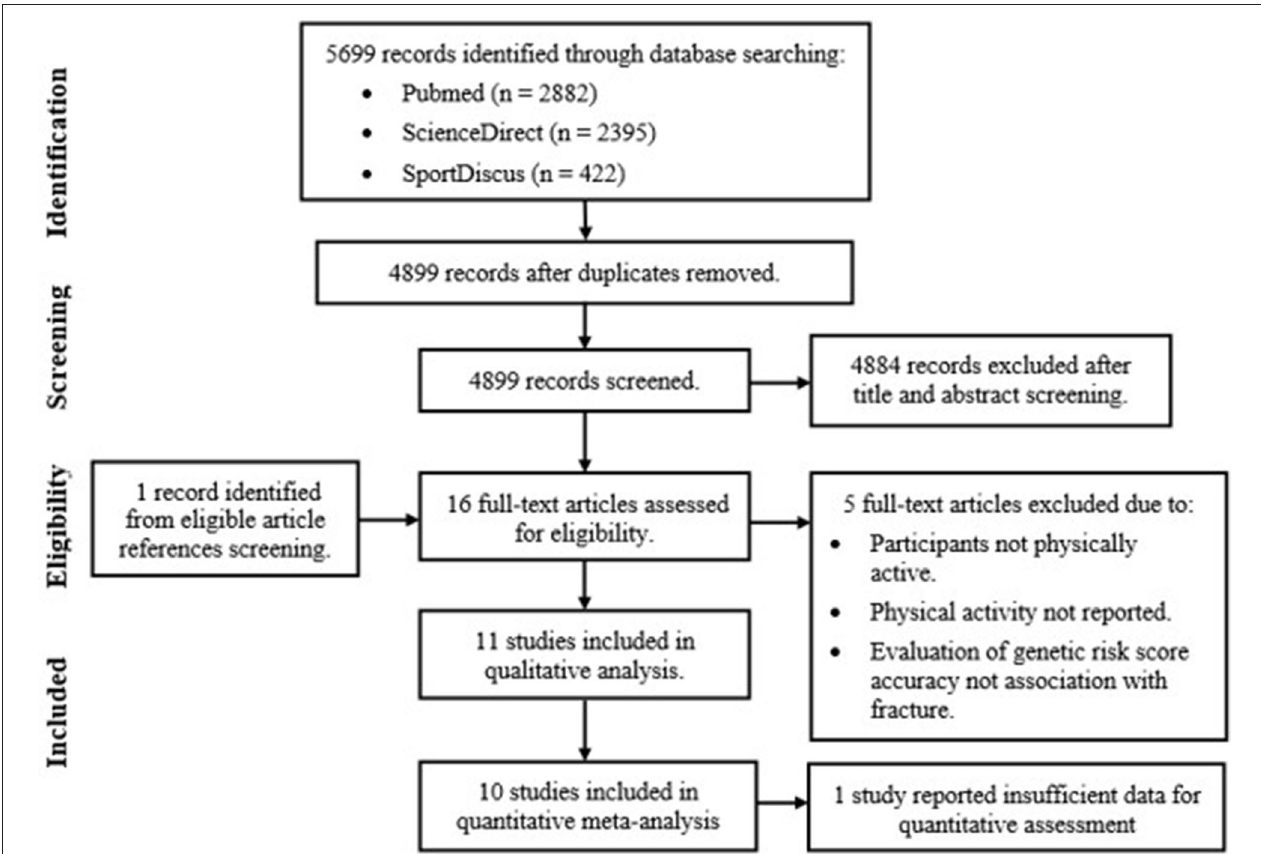
FIGURE 2 | Genetic case-control association study of fracture risk in physically active participant systematic review and meta-analysis study selection process.